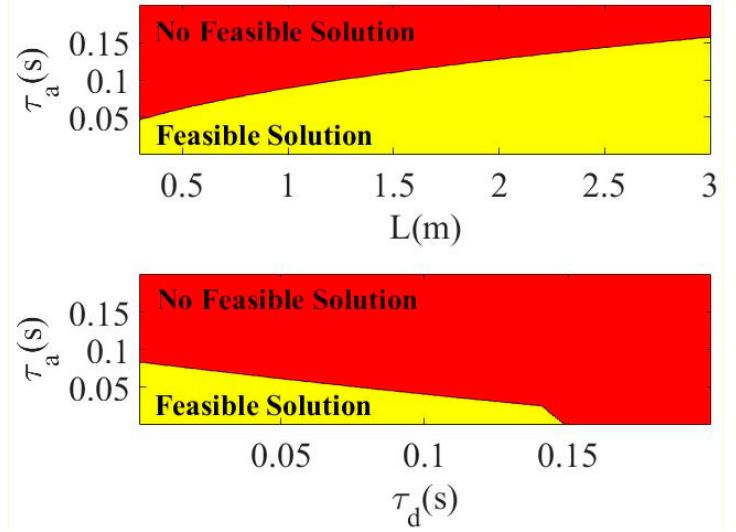
Figure 5. Solution ranges of τ a , τ d , and L of UMZV DRF